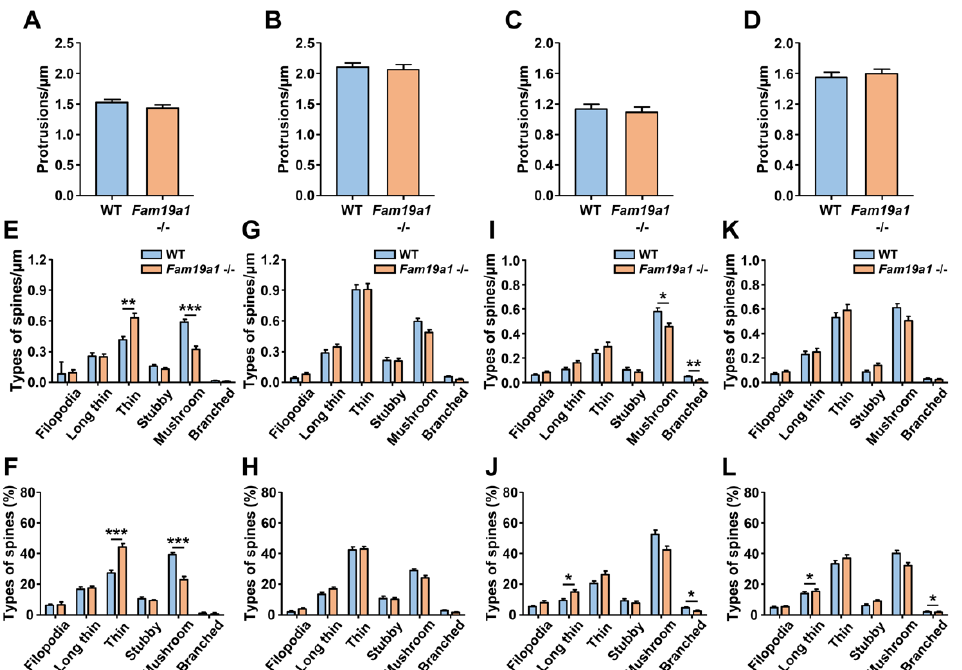
Figure 2. Morphological abnormalities in dendritic spines of motor cortical layer 5 (L5) pyramidal neurons in postnatal Fam19a1 − / − mice. ( A ) Apical dendritic spine density of cortical L5 neurons at postnatal day 15 (P15). ( B ) Basal dendritic spine density of cortical L5 neurons at P15. ( C ) Apical dendritic spine density of cortical L5 neurons at postnatal day 30 (P30). ( D ) Basal dendritic spine density of cortical L5 neurons at P30. ( E ) Density and ( F ) percentage of each spine type among apical dendritic spines of cortical L5 neurons at P15. ( G ) Density and ( H ) percentage of each spine type among basal dendritic spines of cortical L5 neurons at P15. ( I ) Density and ( J ) percentage of each spine type among apical dendritic spines of cortical L5 neurons at P30. ( K ) Density and ( L ) percentage of each spine type among basal dendritic spines of cortical L5 neurons at P30. For each experimental group, three mice were analyzed. Data are presented as means ± standard errors of means (SEM). * p < 0.05, ** p < 0.01, *** p < 0.001 versus WT mice by Mann–Whitney test with Bonferroni correction.